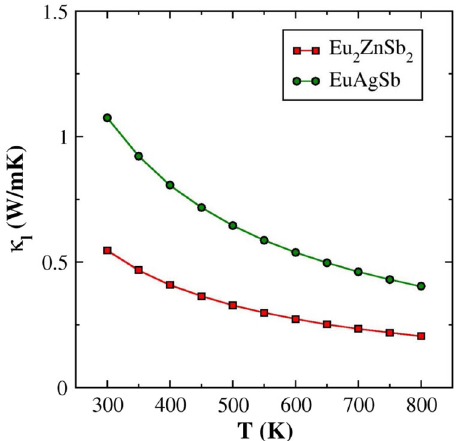
Fig. 5 Calculated temperature-dependent lattice thermal conductivities. These are for ordered zig-zag Eu 2 ZnSb 2 and EuAgSb and are based on anharmonic phonon